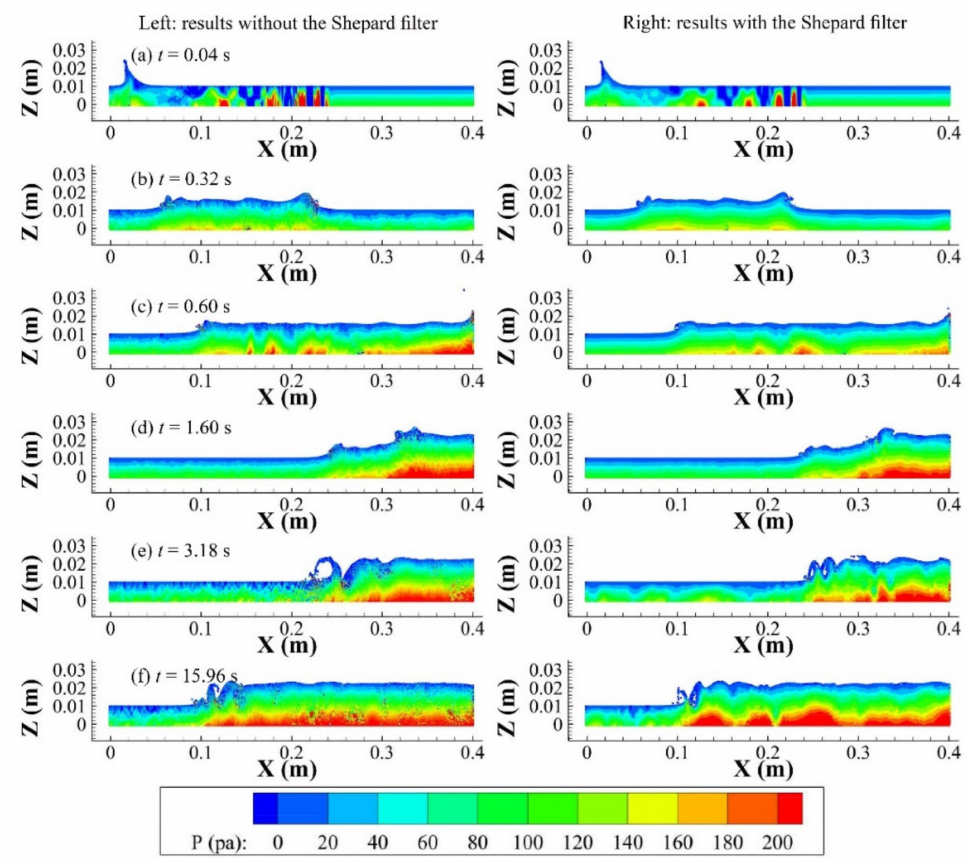
Figure 10. Pressure fields of case